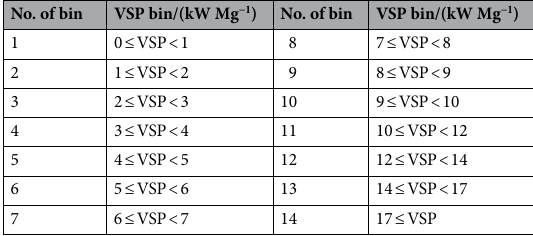
Table 3. Bin partitions of VSP for light-duty diesel